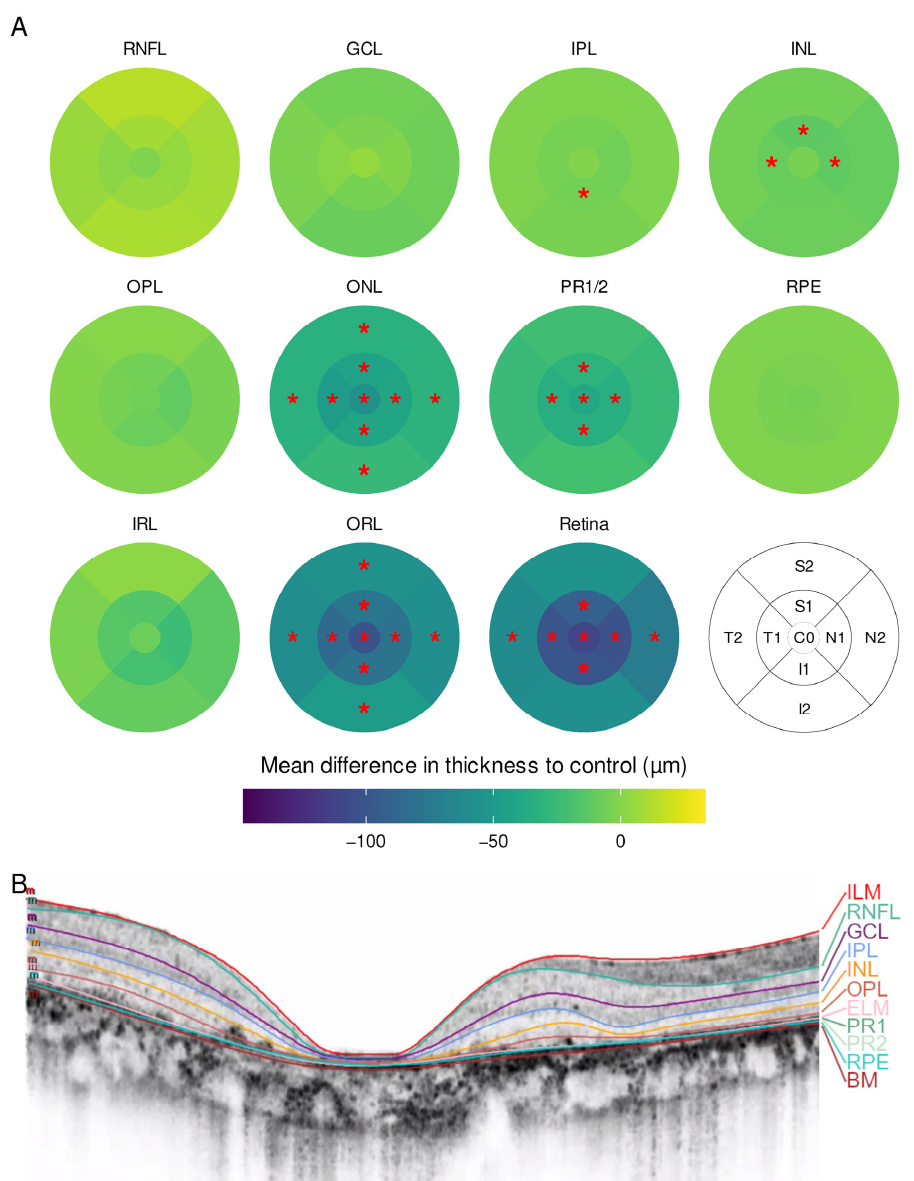
Figure 2. ( A ) Mean difference in layer thickness for cone–rod dystrophy (CRD) compared to controls represented as a heatmap on the ETDRS grid. Significant differences are marked with a red star (*) in the particular subfield; ( B ) example for a manually segmented SD-OCT scan from the fovea from CRD patient